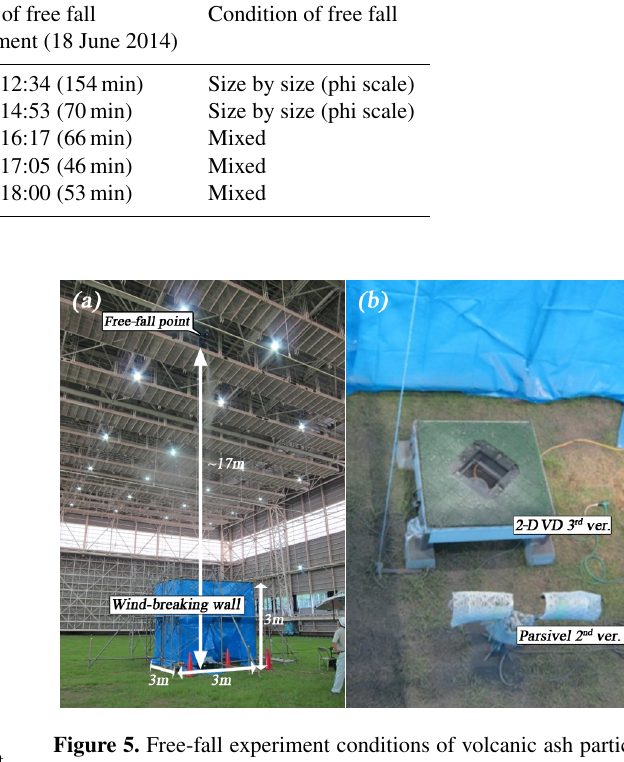
Figure 4. Real images of volcanic ash particles used in the present study. The particles were classified as (a) 0.125mm D ≤ 0 . 25mm, (b) 0.25mm D ≤ 1mm, (c) 1mm D < 2mm, and (d) 2 < D ≤ 4mm.